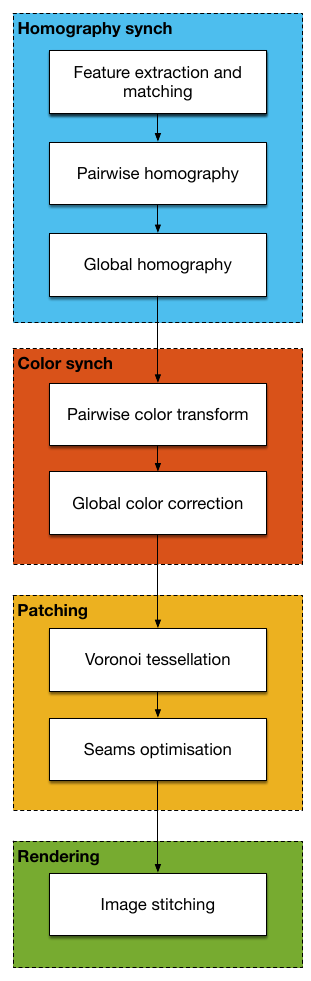
Figure 2. Flowchart of the proposed